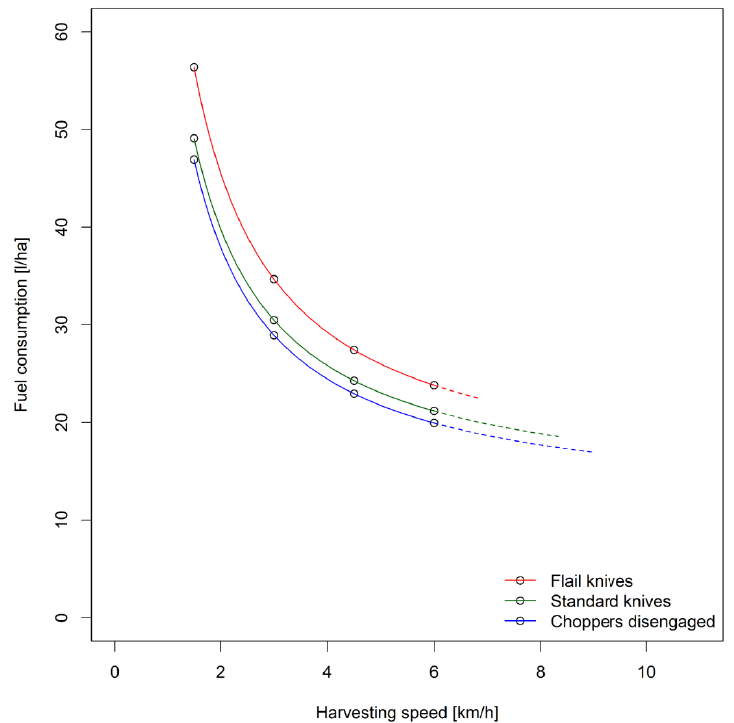
Figure A9. Fuel consumption of the combine harvester depending on harvesting speed for the levels of corn header configuration at cutting height level 2 (Markers indicate harvesting speed levels at cutting height level 2, dashed lines represent extrapolation up to a theoretical engine load of 90%).